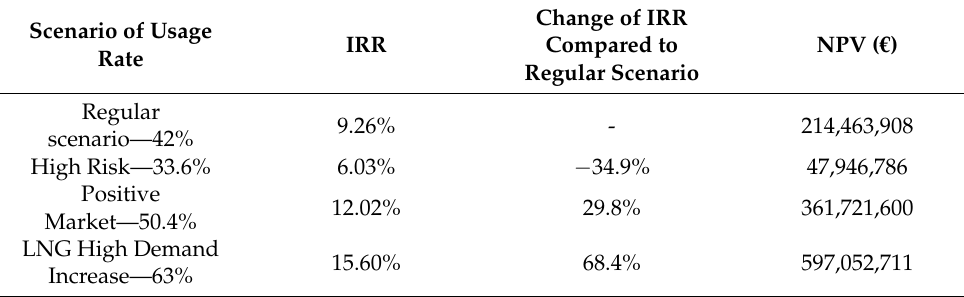
Table 2. Results of demand-usage rate sensitivity analysis.